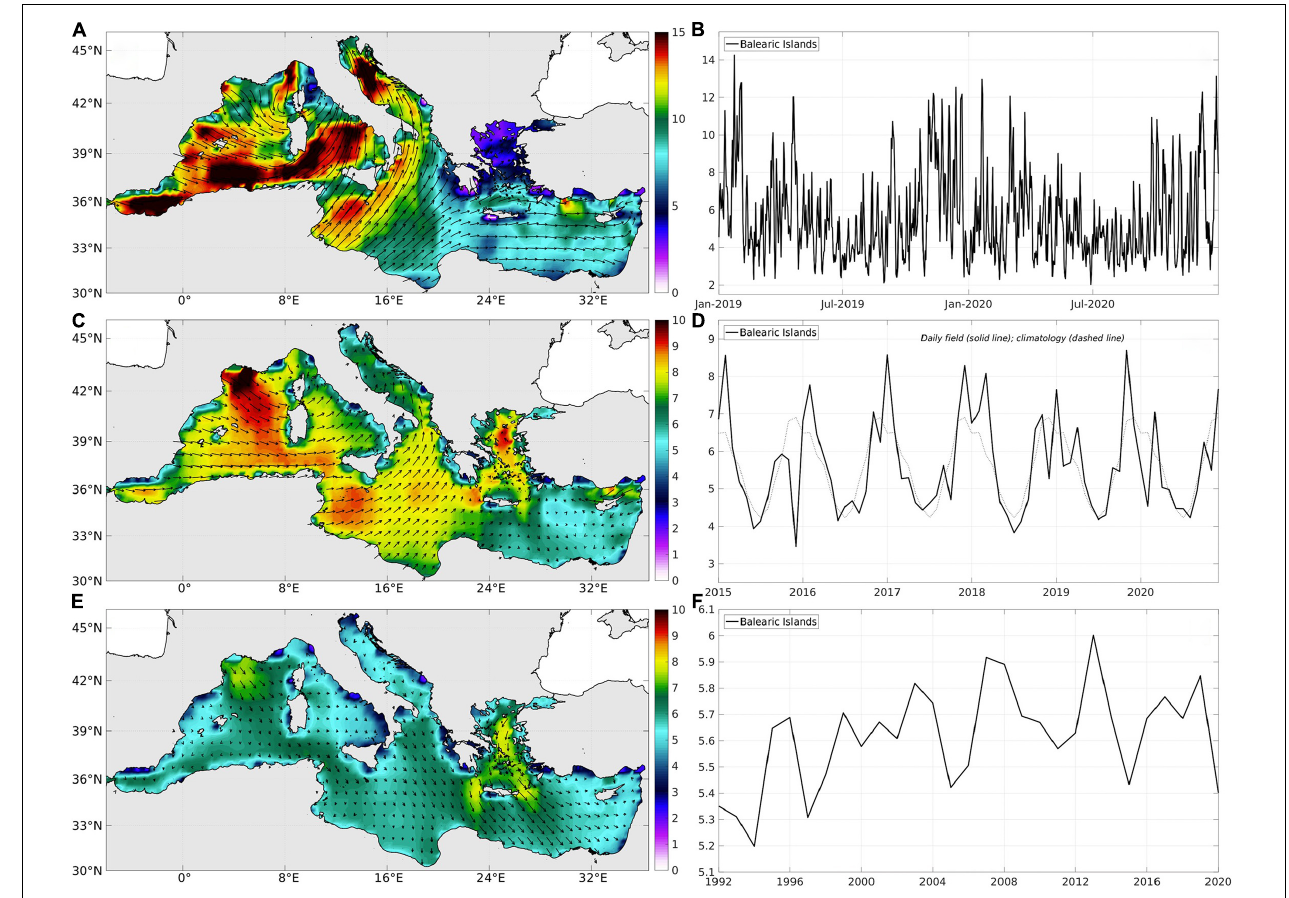
FIGURE 7 | Illustrations for WIND (in m/s): daily mean on 31-December-2020 (A,B) , monthly mean in December 2020 (C,D) , and annual mean in 2020 (E,F) : 2D maps (A,C,E) and time series averaged in the Balearic Islands since 2019, 2015, and 1992, respectively (B,D,F)